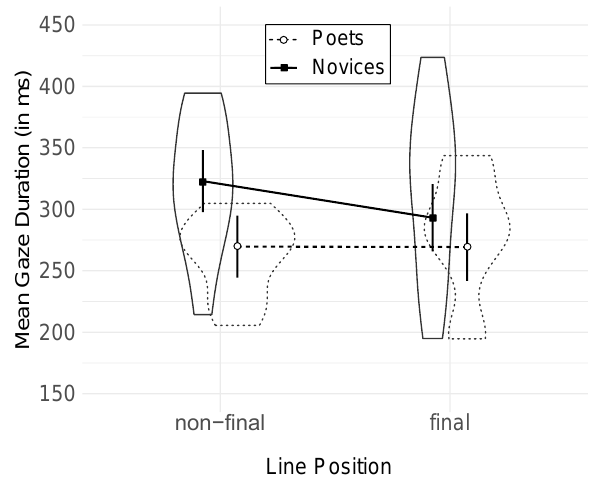
Figure 2. Mean gaze duration per word during poetry reading as a function of line position (non-final vs. final) and level of expertise (poets vs. novices).